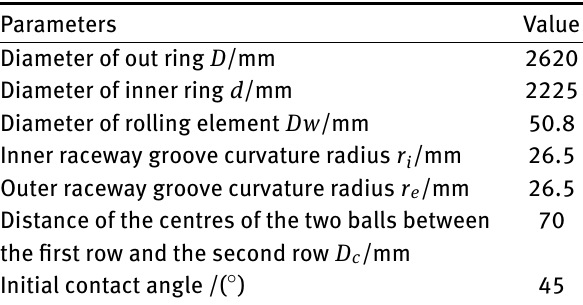
Table 1: Parameters of 2MW pitch